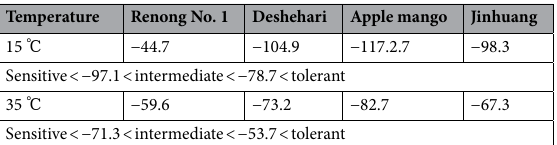
Table 5. CSRI values of four mango genotypes at different temperature